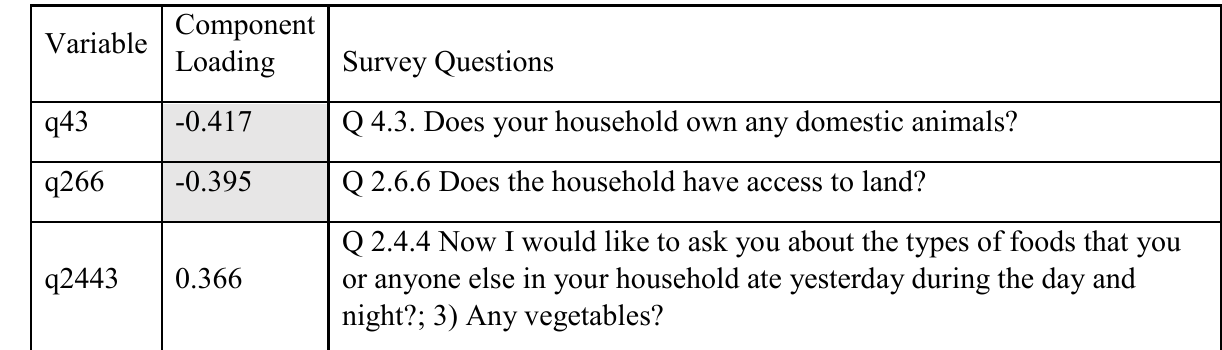
Table 1.16: Variables defining Absorptive Resilience